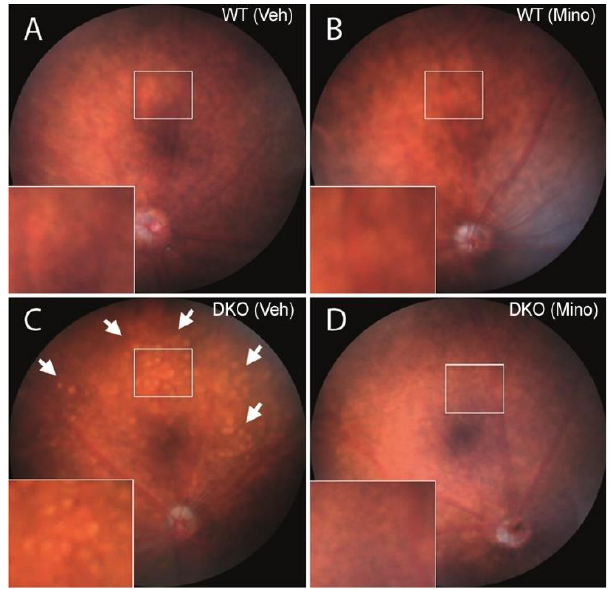
Figure 3. Fundus images of vehicle- or minocycline-treated wild-type (WT) and double knockout (DKO) mice. Fundus images were taken from 9-month-old WT ( A , B ) or DKO ( C , D ) mice following 3 months vehicle ( A , C ) or minocycline ( B , D ) treatment. High-magnification images of rectangle areas were shown in the lower left corner of each image. Arrows—whitish dots. Veh—vehicle; Mino—minocycline.